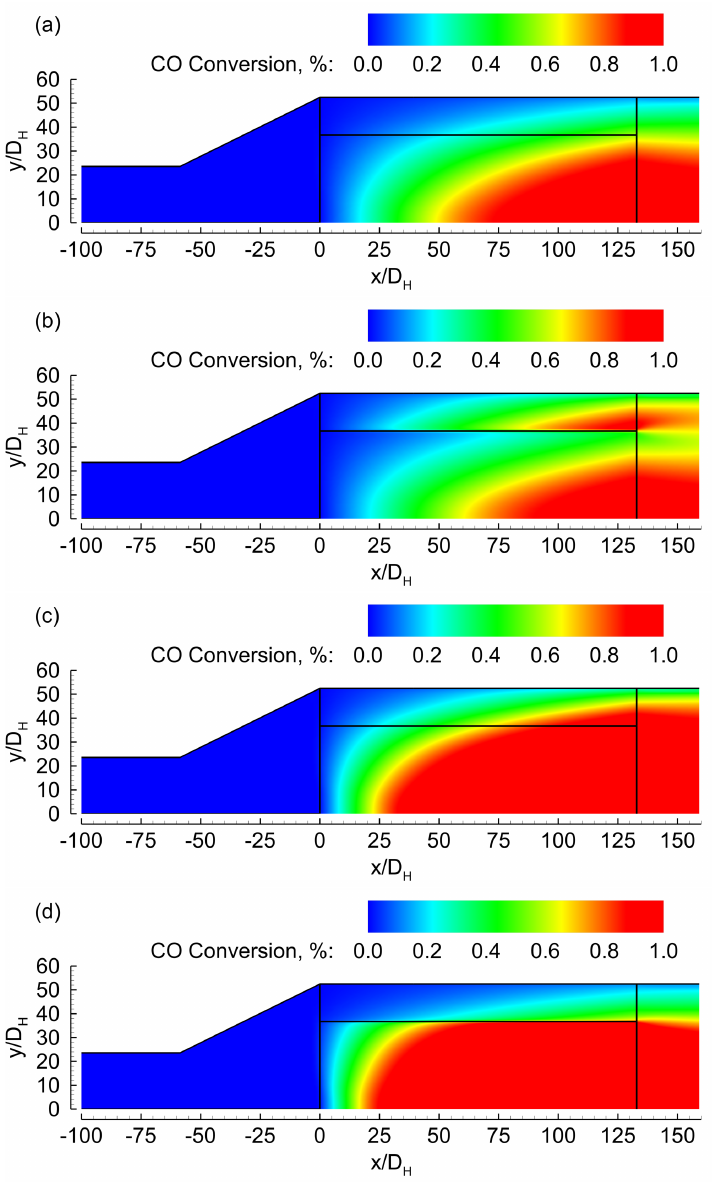
Figure 7. CO conversion. ( a ) 400c/400r, ( b ) 400c/900r, ( c ) 900c/900r, and ( d )